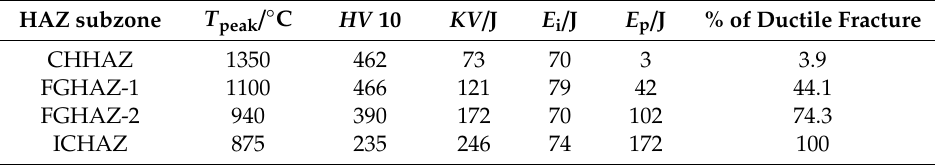
Table 4. Hardness and impact energies of simulated HAZ